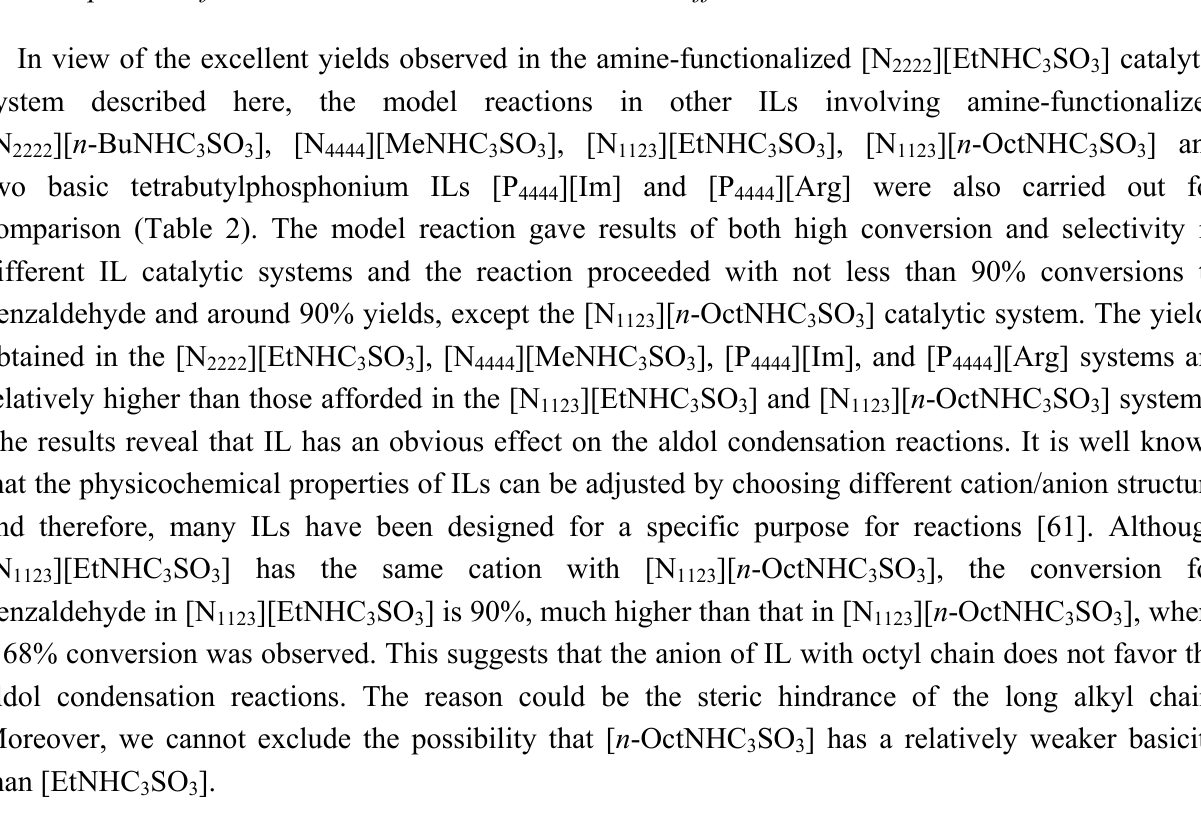
O (1.0 mL H O), 80 2 2